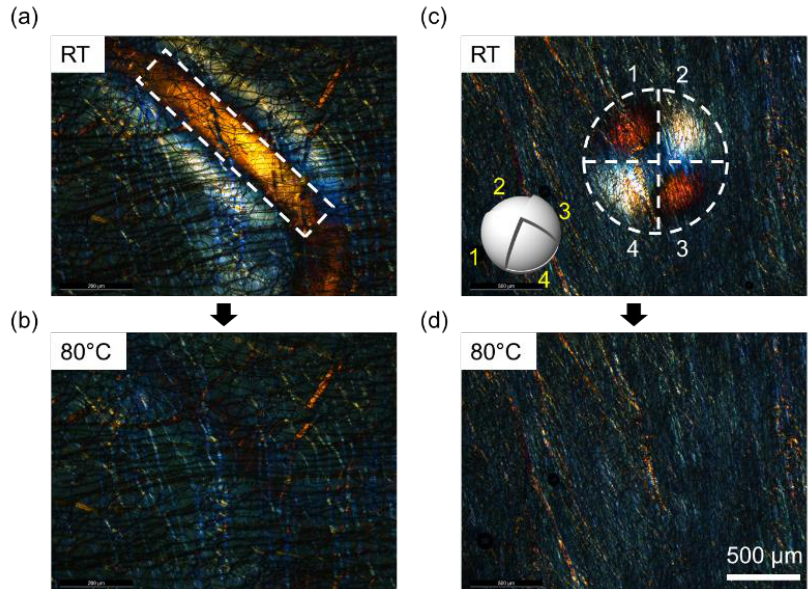
Figure 5. The thermal-mediative shape memory effect of the CLC-PUA composite film (100 µ m thick). ( a , b ) POM images of the CLC-PUA composite film ( a ) upon the compression using a cylindrical-shape compression applier, and ( b ) recovered to the pristine state by heating. ( c , d ) POM images of the CLC-PUA composite film ( c ) upon the compression using a spherical-shape compression applier with a patterned protrusion (inset), and ( d ) recovered to the pristine state by heating. In ( c ), the numbers represent the labeled protrusions and the compressed regions by corresponding protrusions.